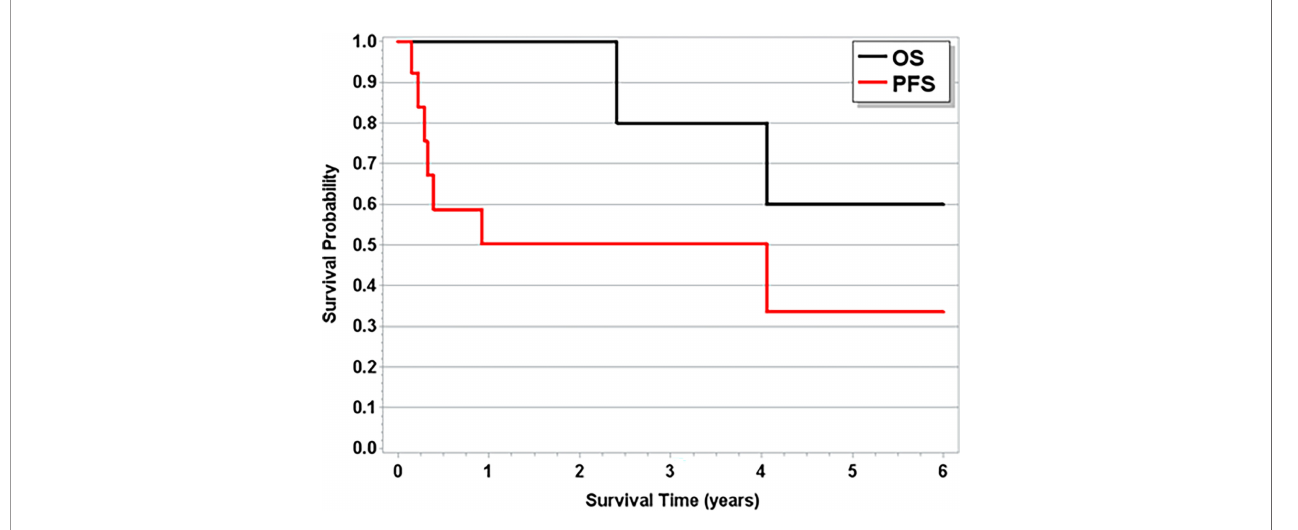
FIGURE 2 | Overall Survival and Progression Free Survival for Patients with T-LGLL.